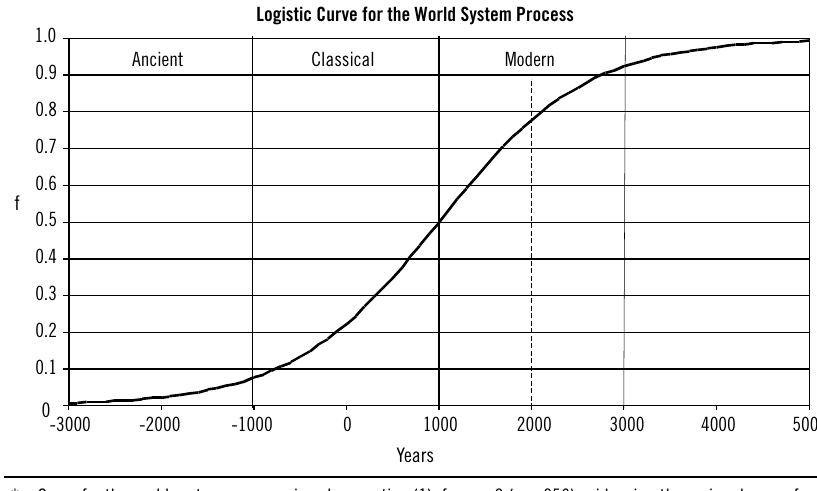
Figure 1 – The Four-Phased Millennial Learning Process of the World System*